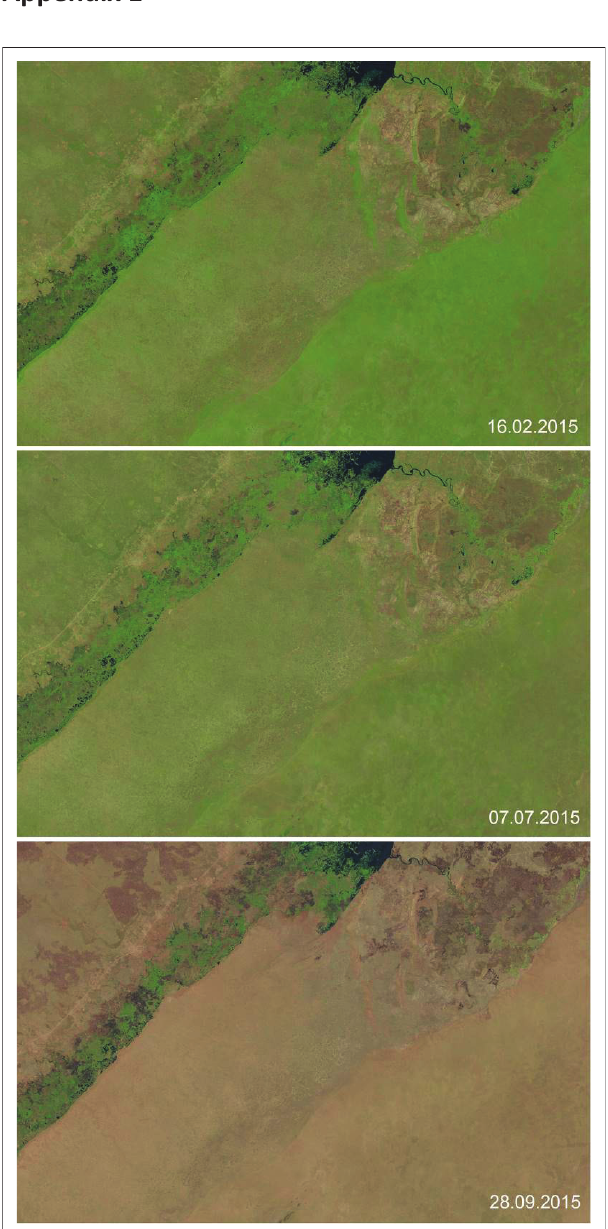
FIGURE 1-A1: True colour Landsat 8 images of the Chobe Enclave for the different seasons: February is in the middle of the rainy season, May at the end of the rainy season and September in the dry